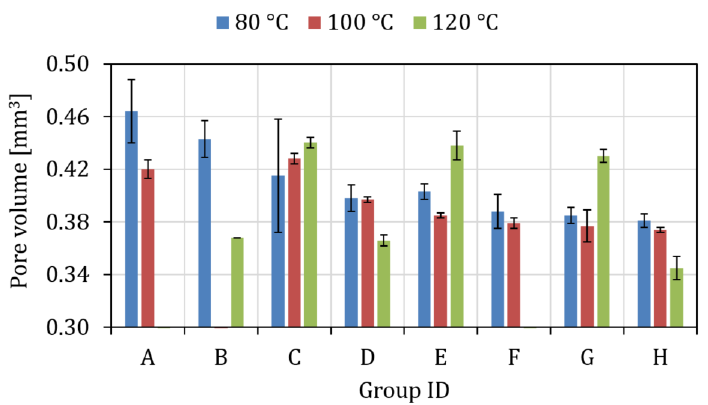
Figure 3. CT Measurement results of total pore volume (the standard deviations related to two different parts are